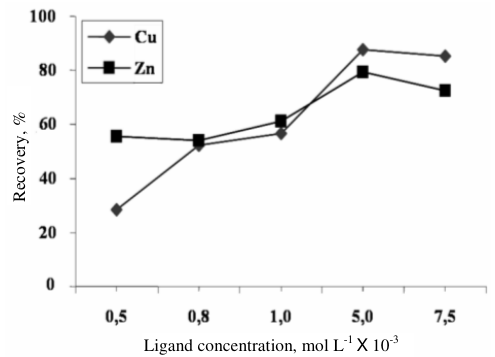
Figure 3. The effect of the chelating agent concentration on the recovery of the metal ions.